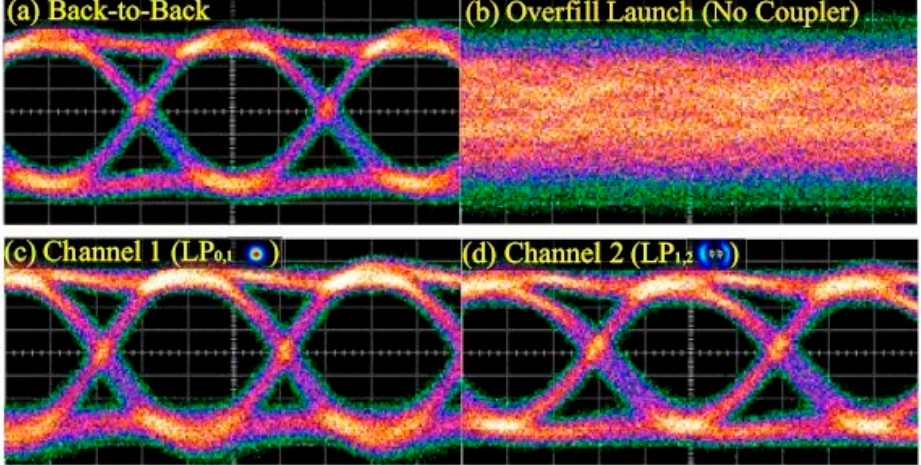
Figure 5. Eye diagrams of a typical mode-division multiplexing (MDM) transmission system for ( a ) back-to-back; ( b ) over-fill launch without coupler; ( c ) LP 01 channel; ( d ) LP 12 channel [26].